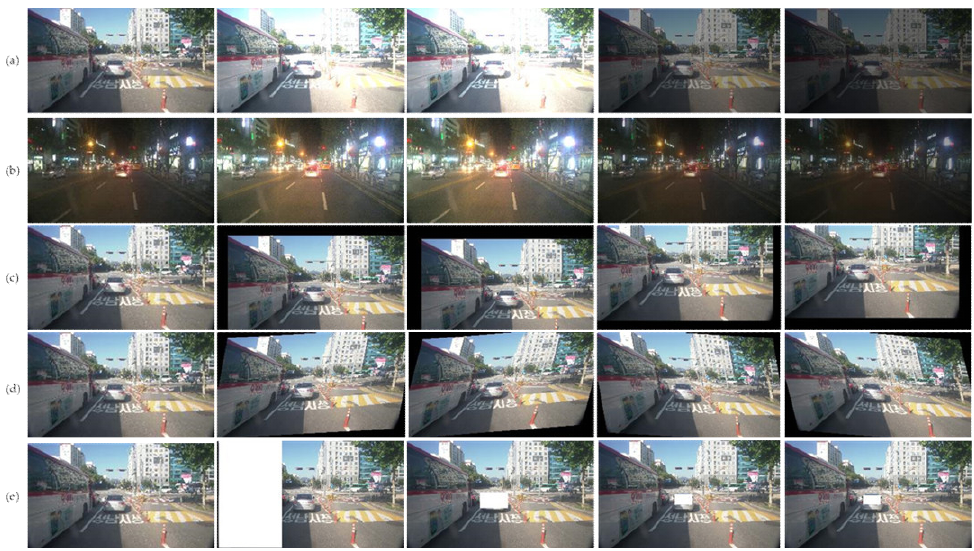
Figure 12. Augmentation brightness factor control example: ( a ) original image, ( b ) −30% bright- ness, ( c ) −15% brightness, ( d ) +30% brightness, and ( e ) +15% brightness.